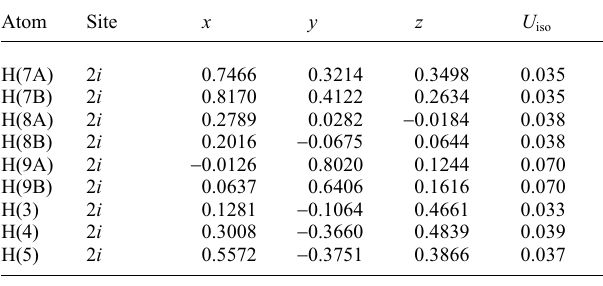
Table 3. Atomic coordinates and displacement parameters (in Å 2 ) .